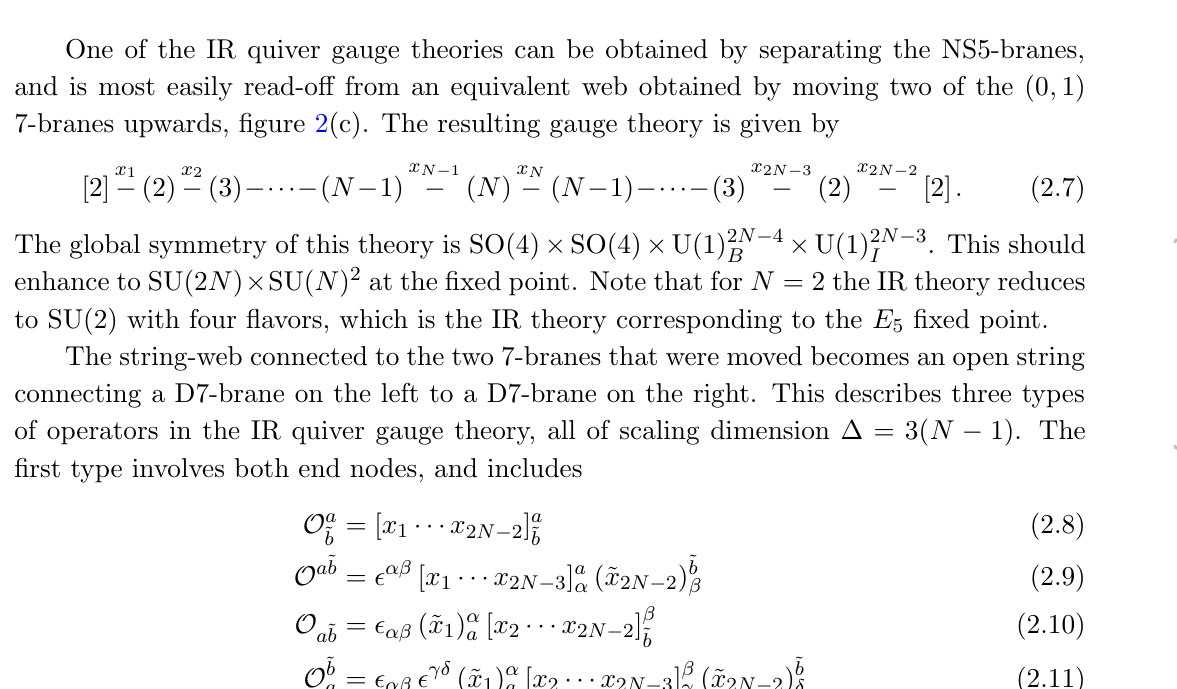
Figure 2. Brane webs for the Y N theory with N = 3, with the string junction/open strings representing the long